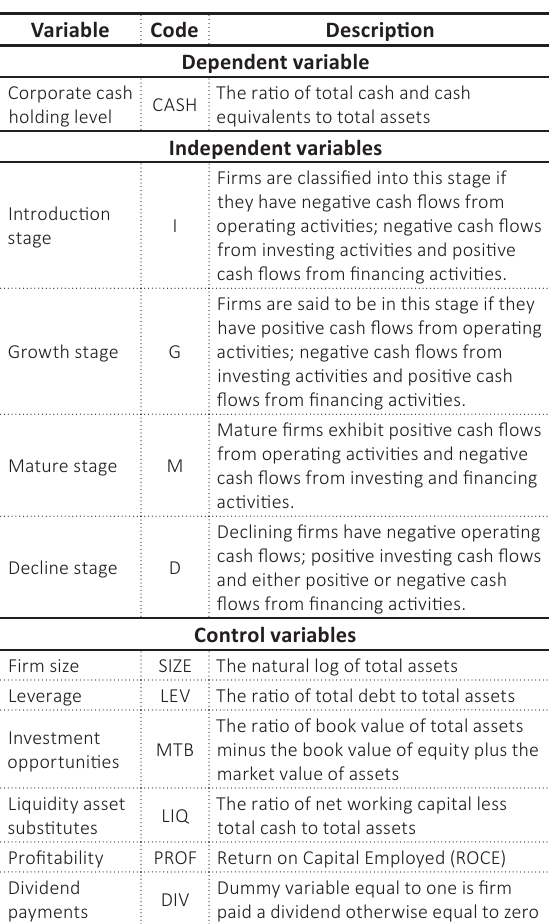
Table 2. Definition of